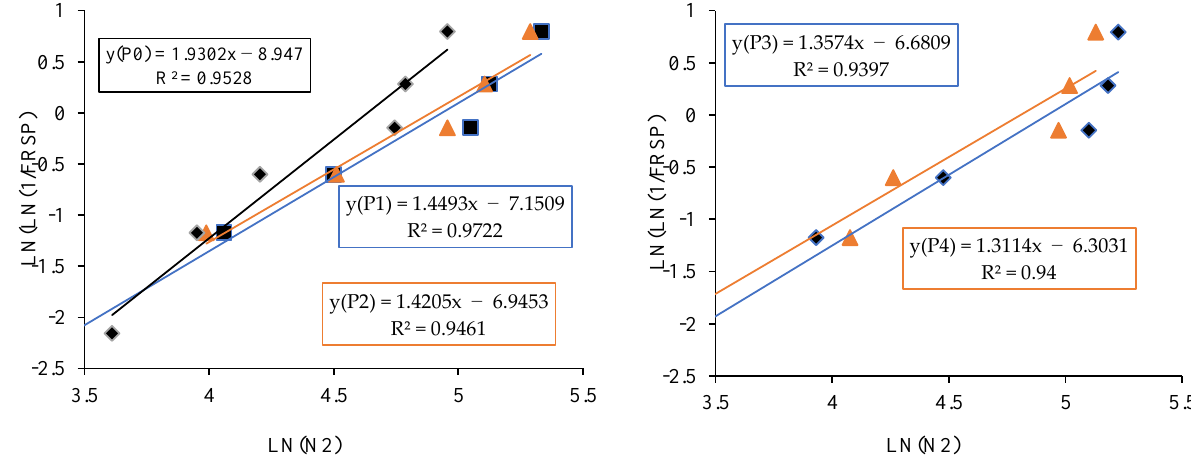
Figure 18. Weibull distribution for P0, P1, P2, P3 and P4 mixes at initial crack on 14 days.